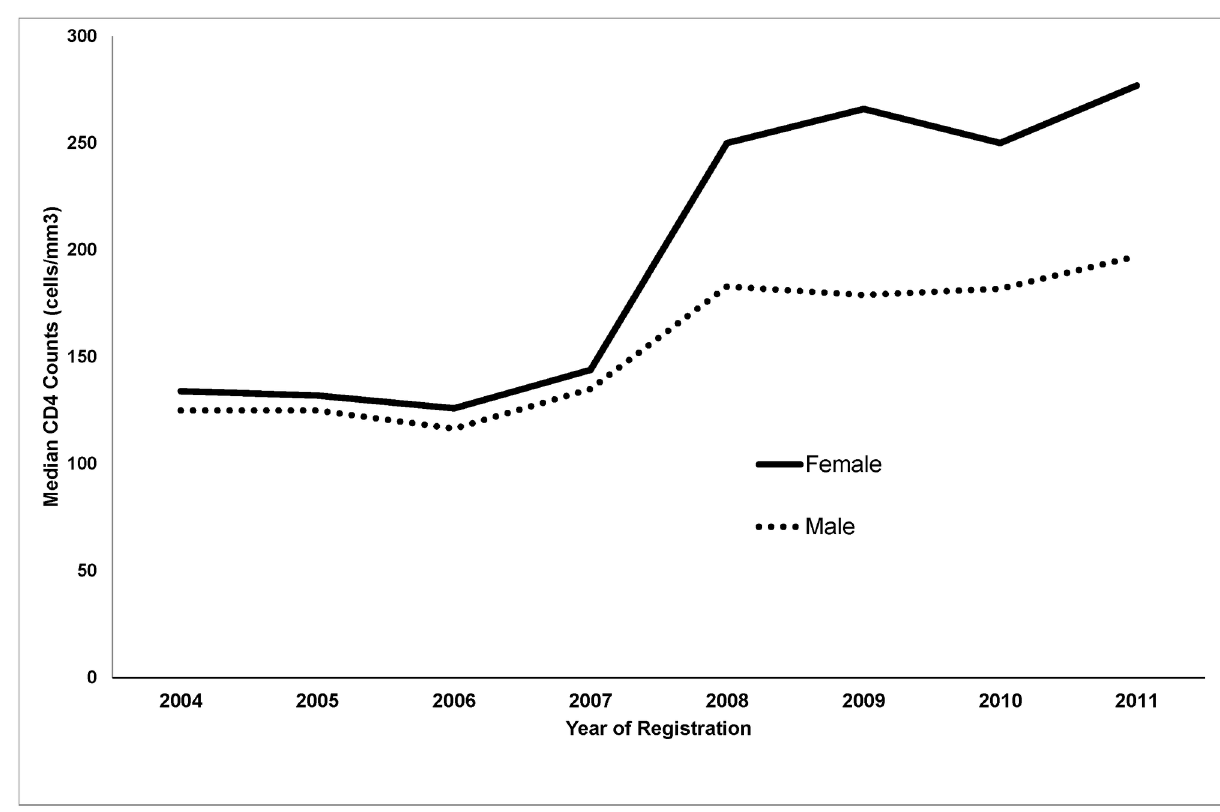
Figure 3. Trends in median baseline CD4 counts of newly diagnosed HIV-infected individuals registered for HIV care